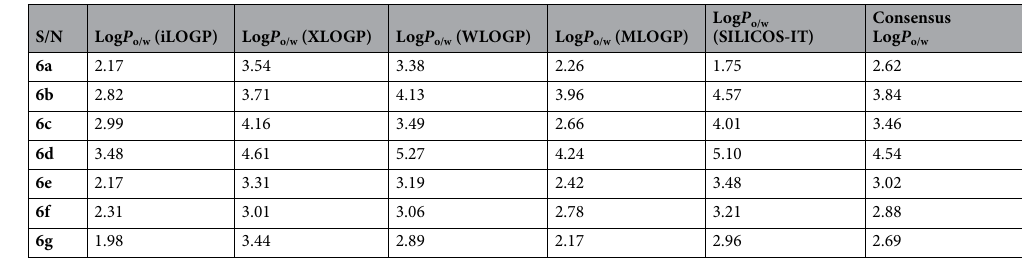
Table 2. Lipophilicity.